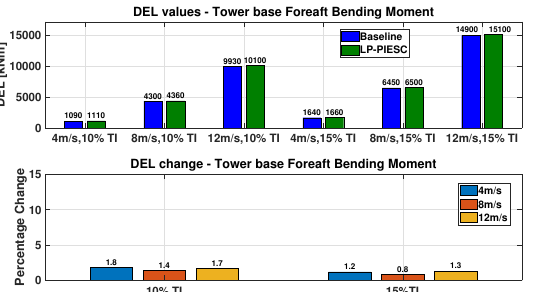
Figure 16. Tower- base fore-aft bending moment comparison: Baseline vs. LP-PIESC. Aggregate DEL values with baseline controller and LP-PIESC ( top ), percentage change in DEL for time series from 150 s to 3000 s.